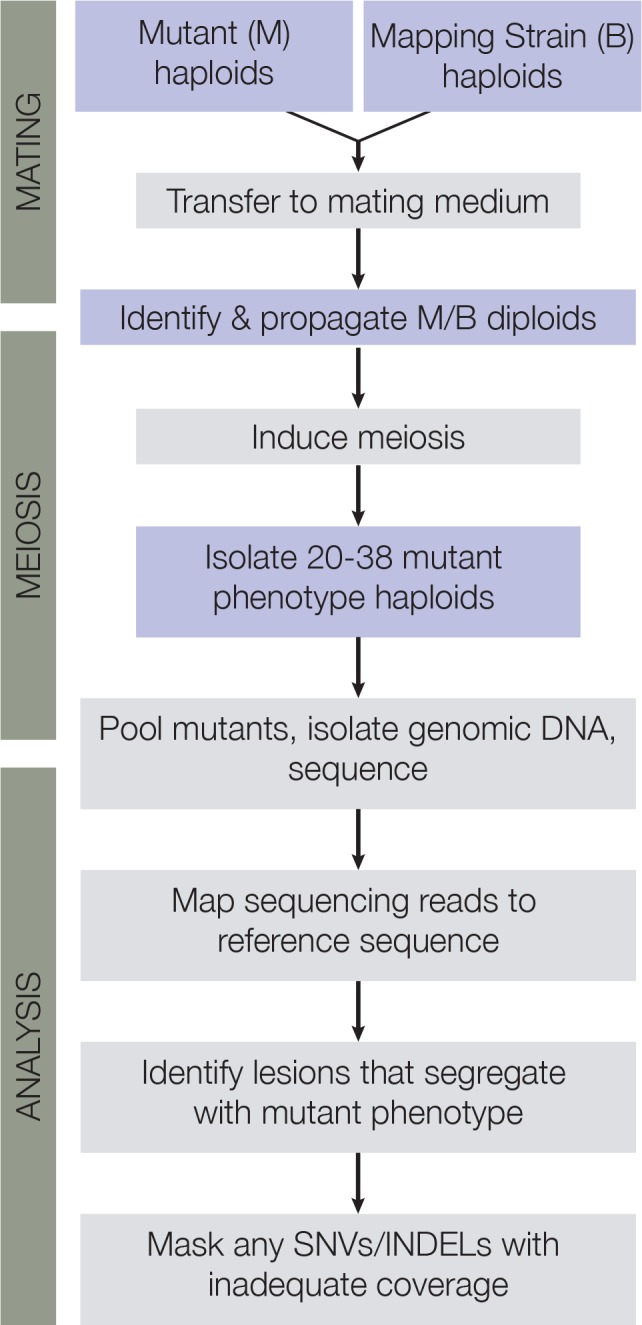
Mapping cross scheme.Flow chart of the steps used in mapping cross and bulk segregant analysis.